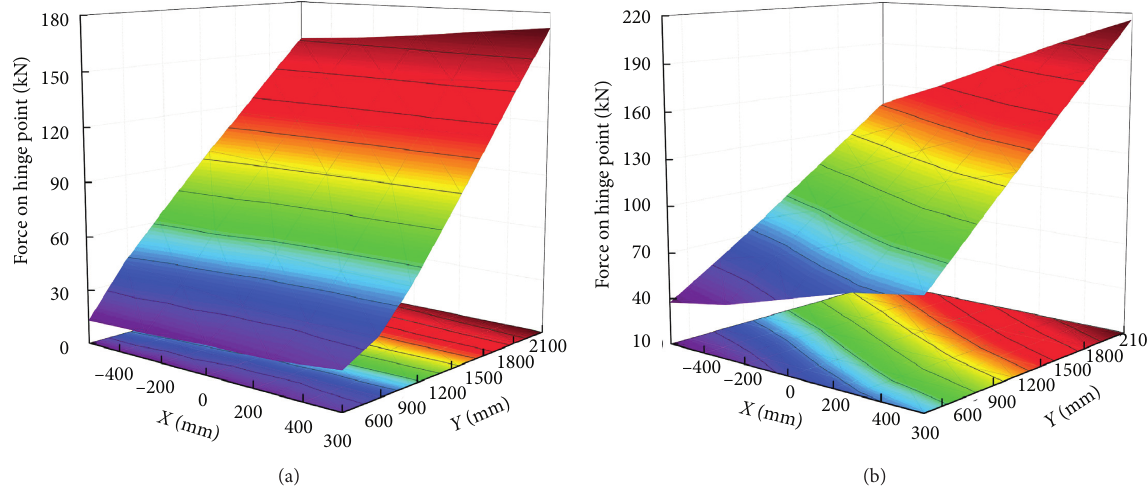
Figure 16: Load-bearing characteristics of the hinge joint of the face guard. (a) Load-bearing characteristics of the hinged joint of the integral face guard. (b) Load-bearing characteristics of the hinged joint of the split face